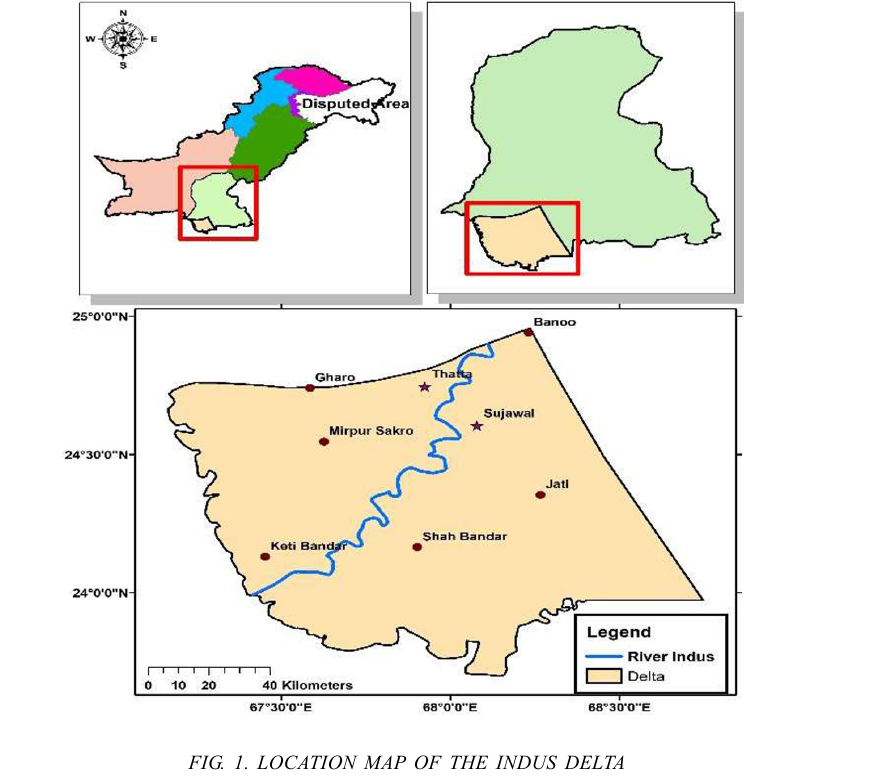
FIG. 1. LOCATION MAP OF THE INDUS